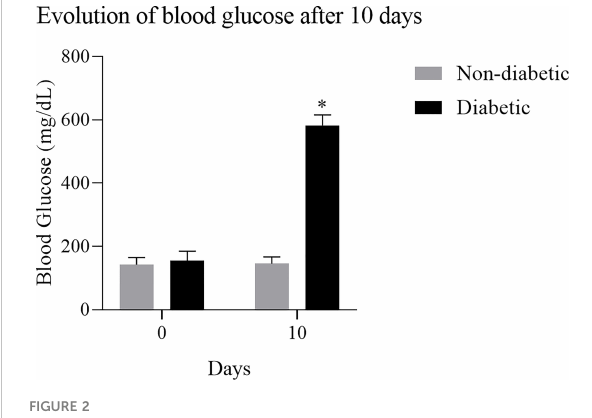
FIGURE 2 Evolution of blood glucose after induction of diabetes: Diabetic animals showed an increase in blood glucose after 10 days of induction with the diabetogenic agent. Results expressed in Sidak Simultaneous Comparison Test *p<0.005,